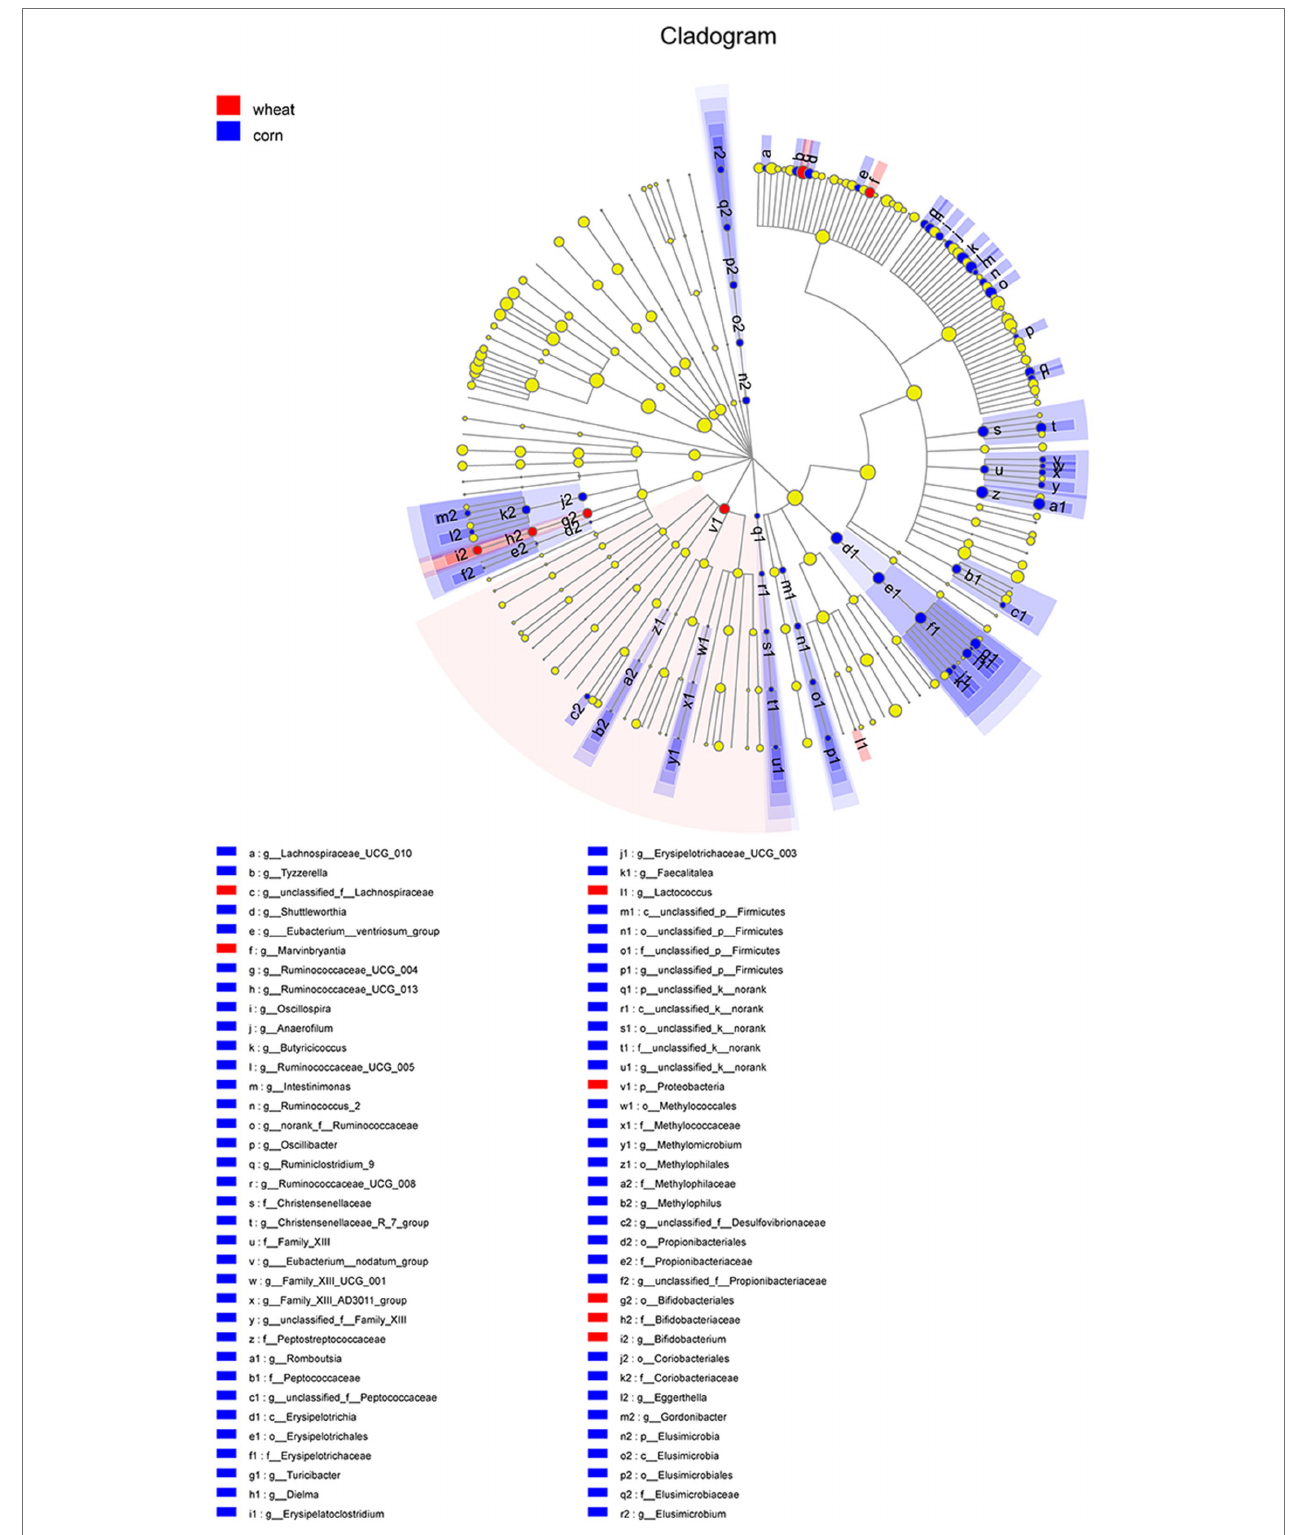
FIGURE 8 | The LEfSe analysis for cecal bacteria communities from phylum to genus level in broilers fed wheat- or corn-based diets. The circles from inner to outer represent distinct bacteria from phylum to genus level, respectively. The yellow dots inserted in the circle demonstrated no significant differences in bacteria communities between two dietary